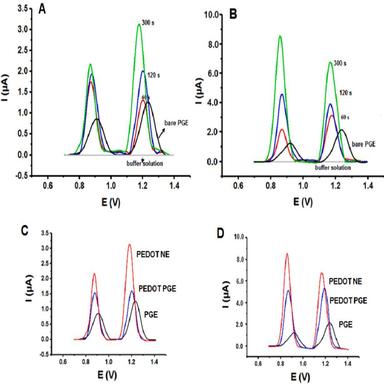
A) (250 mg L− 1 dsDNA) and B) (500 mg L− 1 dsDNA): DPVs of PEDOT NEs after dsDNA accumulation for various accumulation times (behavior of the PEDOT NE in buffer solution and the behavior of the PGE after dsDNA accumulation with 300 s were also included), C) (250 mg L− 1 dsDNA) and B) (500 mg L− 1 dsDNA): DPVs of PEDOT NE, PEDOT PGE and PGE after 300 s of dsDNA accumulation.